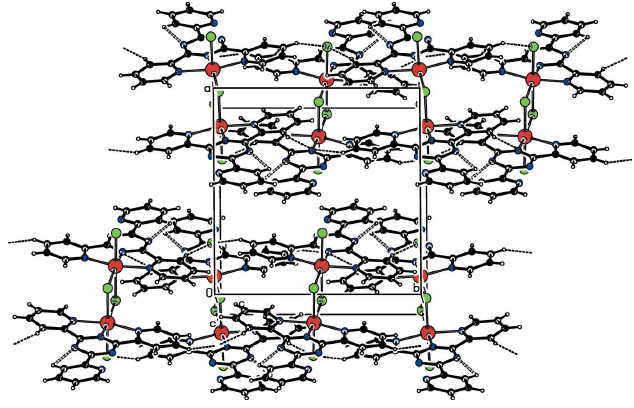
Figure 2 Crystal structure of the title compound showing (cid:2) – (cid:2) interactions as well as weak C–H (cid:3)(cid:3)(cid:3) Cl hydrogen bonds.